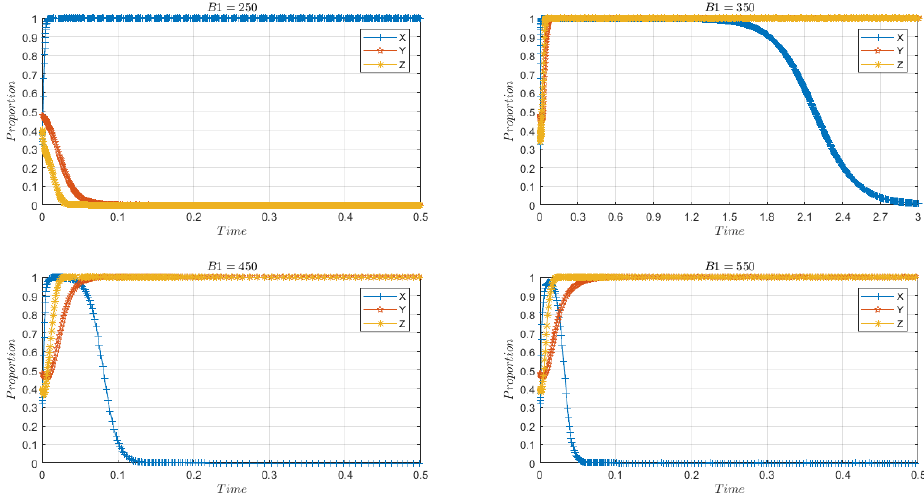
Figure 5. Evolution path of each stakeholder in System A under different farmers’ subsidies.